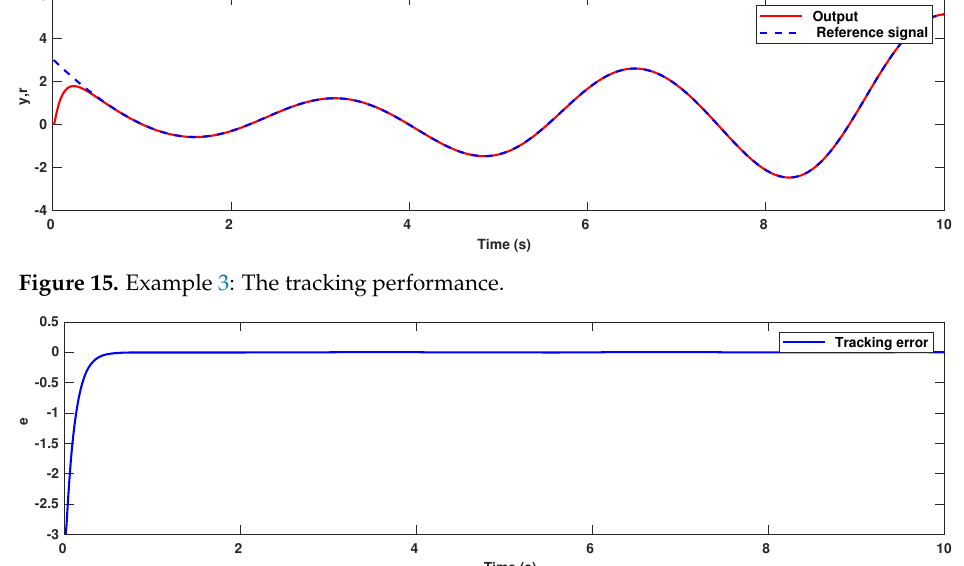
Figure 16. Example 3: Tracking error.